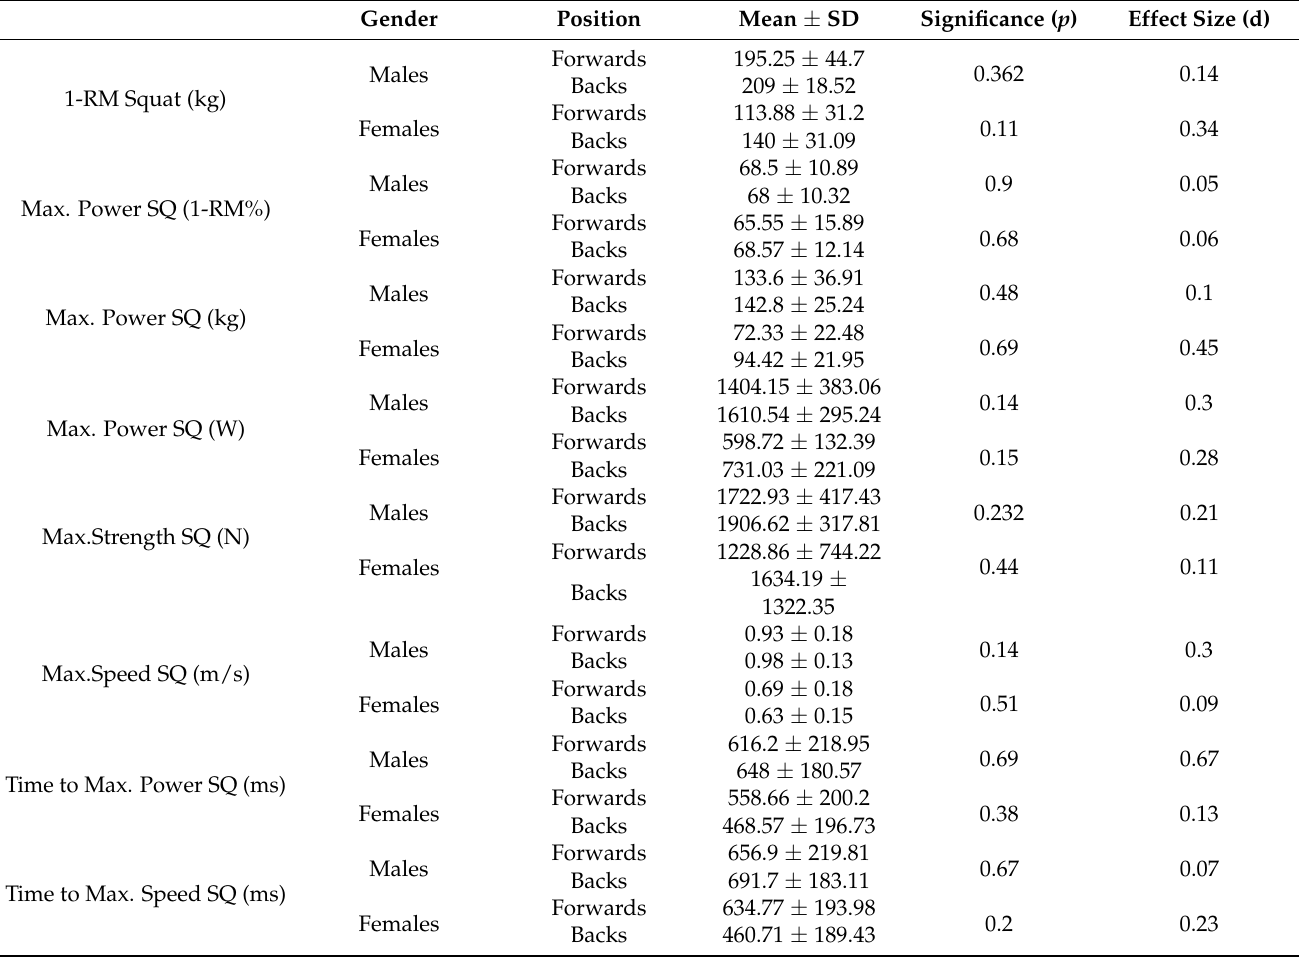
Table 2. Squat comparisons between positions by gender.